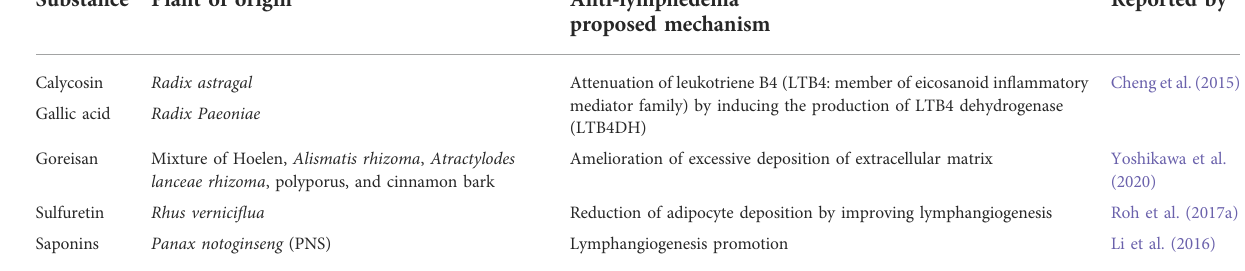
TABLE 3 Some herbals/phytochemical substances with promising anti-lymphedema properties. Substance Plant of